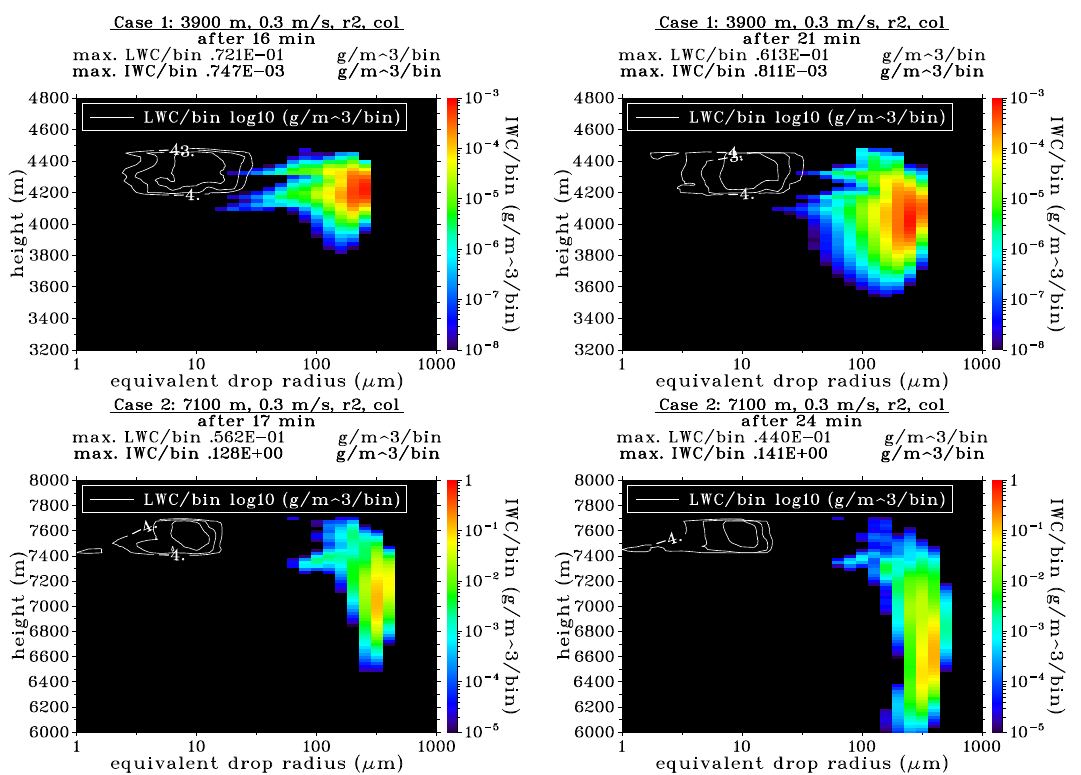
Figure 21. LWC (contours) and ice water mass per bin (colors, both logarithmic scale) for case 1 (upper panel) and case 2 (lower panel) assuming columns as ice particle shape at IWP maximum of the respective base case (left) and at IWP of the run